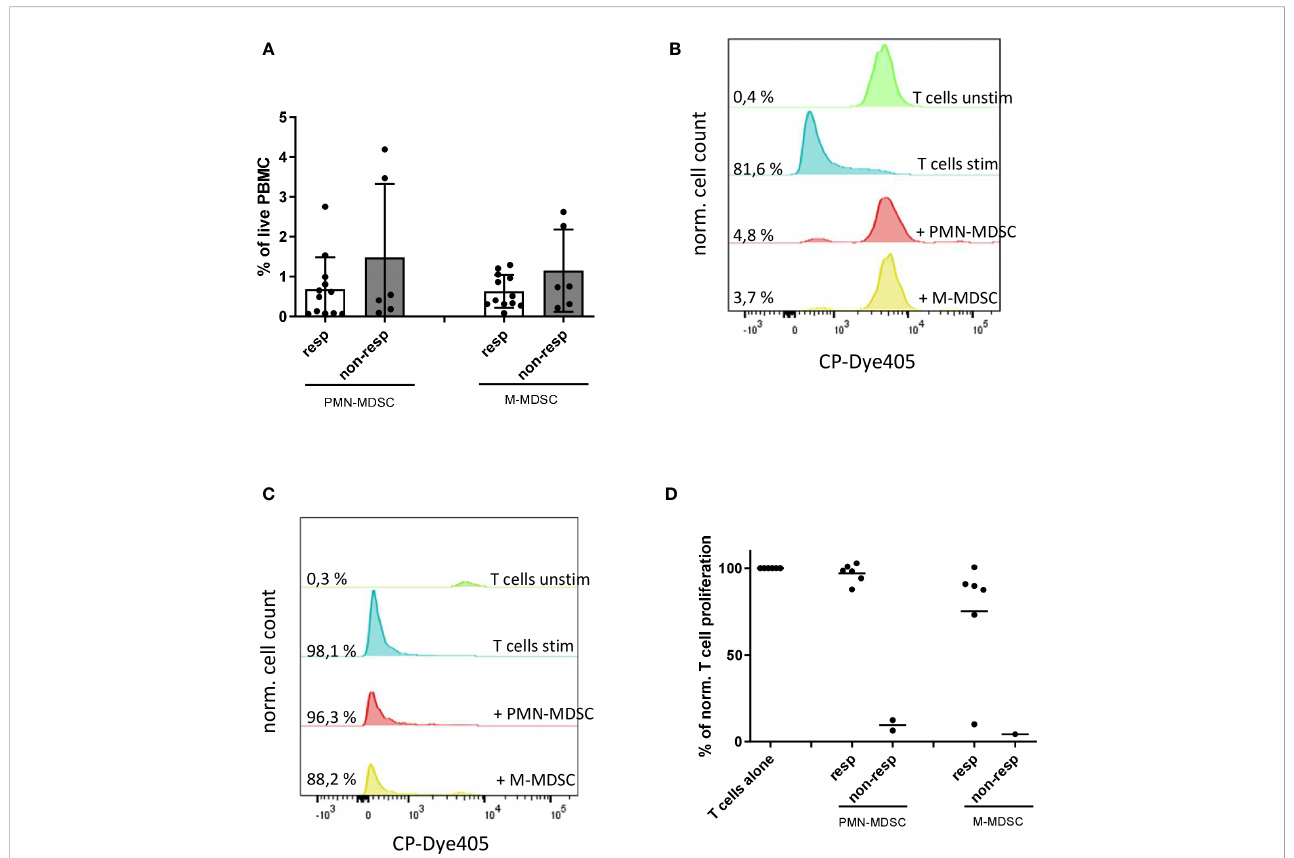
FIGURE 3 Baseline characteristics of PMN- and M-MDSC from responders and non-responders. (A) Results are presented as the frequency of circulating PNM- and M-MDSC among live PBMC from responders (n=12) and non-responders (n=6). Representative histograms for the proliferation of unstimulated (unstim) and stimulated (stim) T cells incubated alone or in the presence of isolated PMN- or M-MDSC from a non-responding (B) and responding patient (C) . (D) Immunosuppressive capacity of PMN- and M-MDSC was determined upon the co-culture with activated CD3 T cells labeled with CP-Dye405. Cumulative data for T cell proliferation are shown as the percentage of divided T cells normalized (norm.) to the respective control of stimulated T cells alone